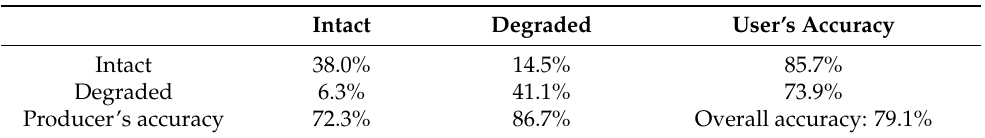
Table 8. Error matrix of Shark River mangrove degradation model. Cell entries represent percent of area. Map categories are in rows while the reference categories are in columns.